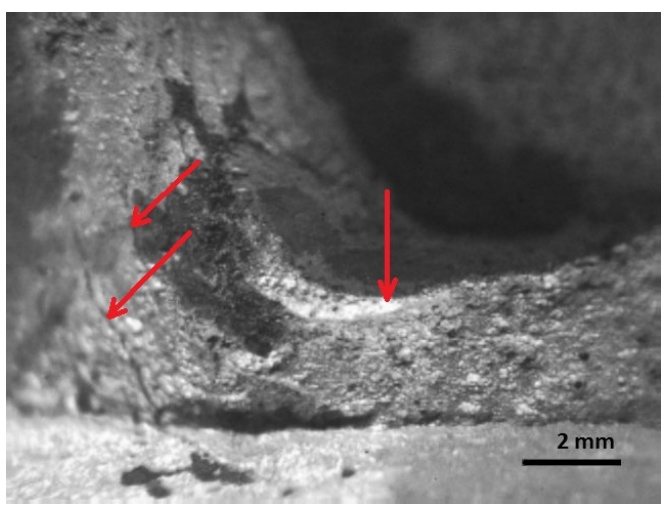
Figure 17. Fracture area: wider view of the area of the focal point of decay.